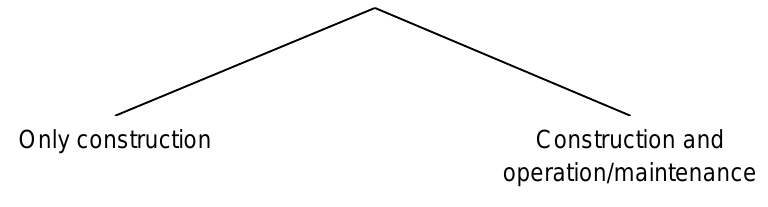
Figure 1: Initial decision when producing a contract in the infrastructure sector (Source: authors)